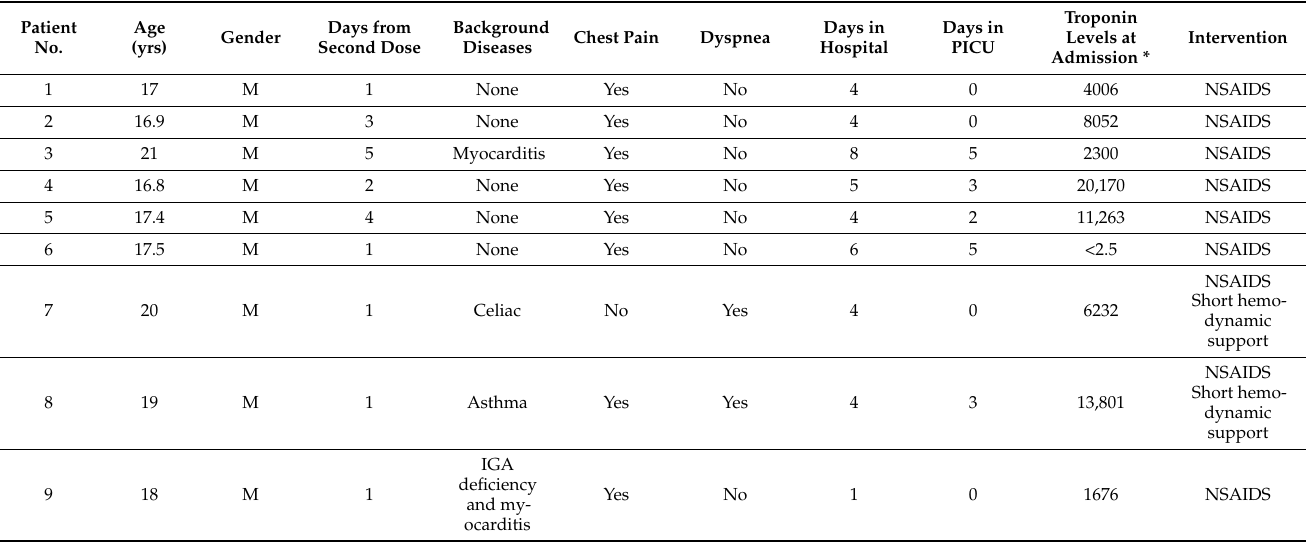
Table 1. Clinical and epidemiological data for nine patients presenting with myocarditis following COVID-19